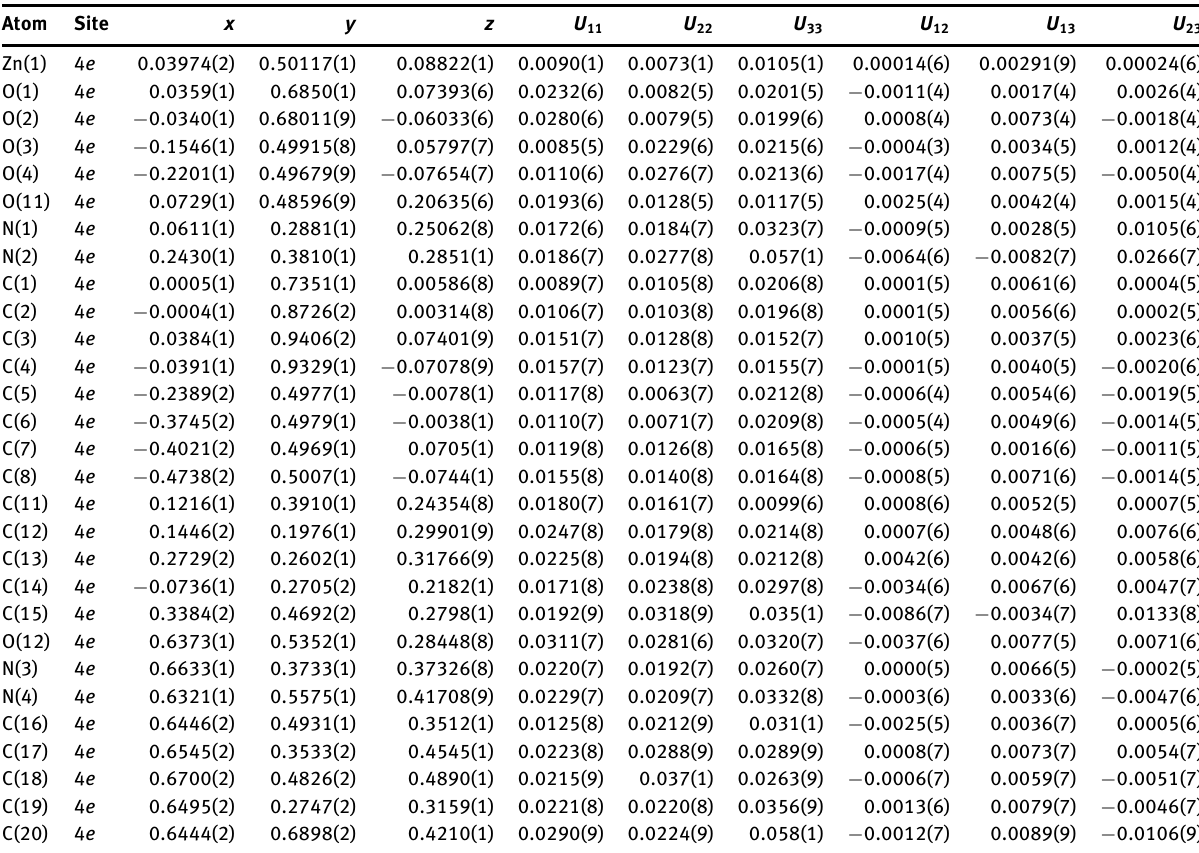
Table 3: Atomic coordinates and displacement parameters (in Å 2